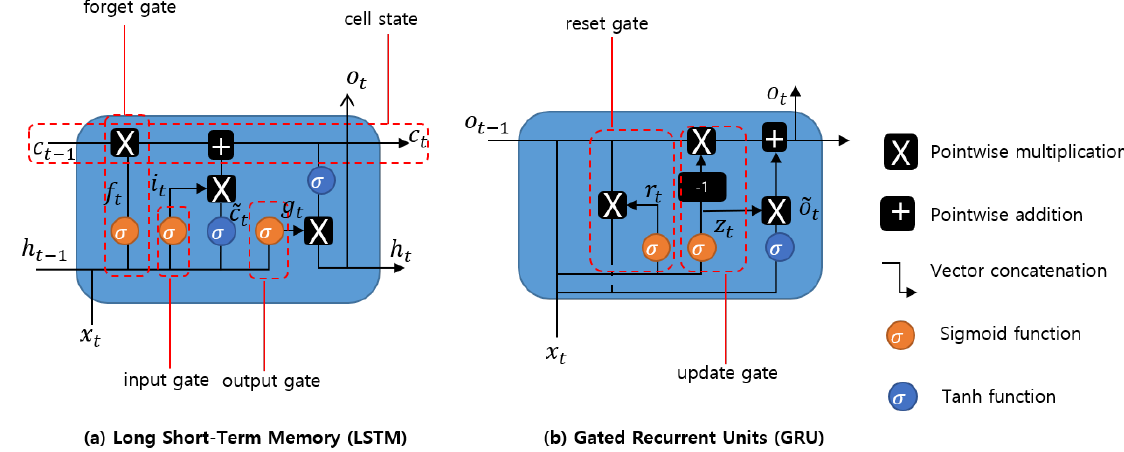
Figure 3. Different cell units and their respective operations of hidden layers in Recurrent Neural Networks; Long ShortTerm Memory, Gated Recurrent